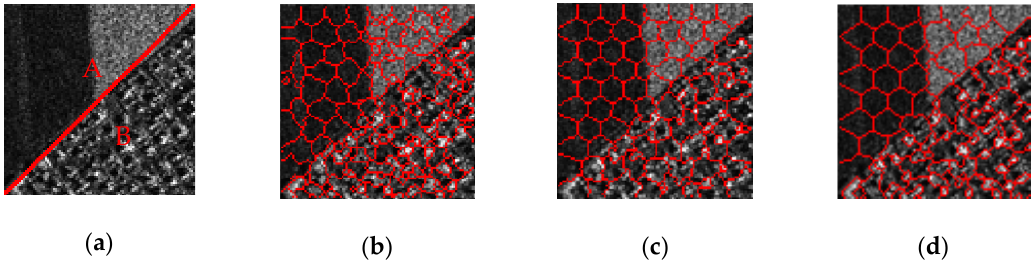
Figure 6. Superpixel results with different compactness parameters in hybrid regions: ( a ) Original SAR image of hybrid regions A and B; ( b ) Results with constant compactness parameter m set to five; ( c ) Results with constant compactness parameter m set to 10; ( d ) Results by adaptive local compactness (ALC) with the global compactness parameter m g set to 10.